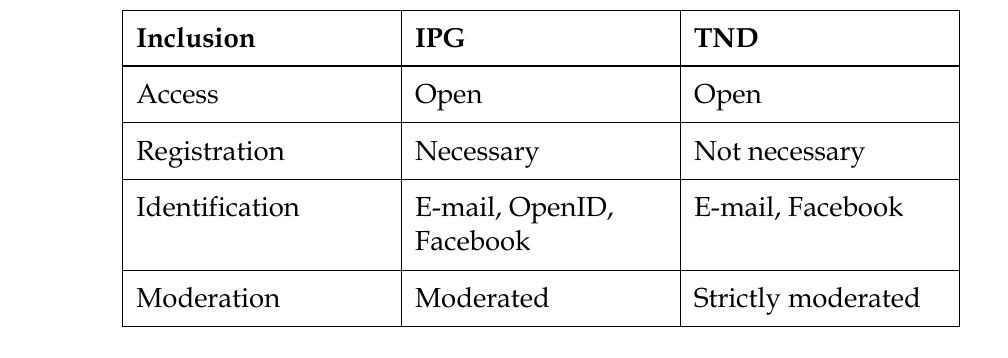
Table 2: The Dimension of Context on the IPG and TND Online